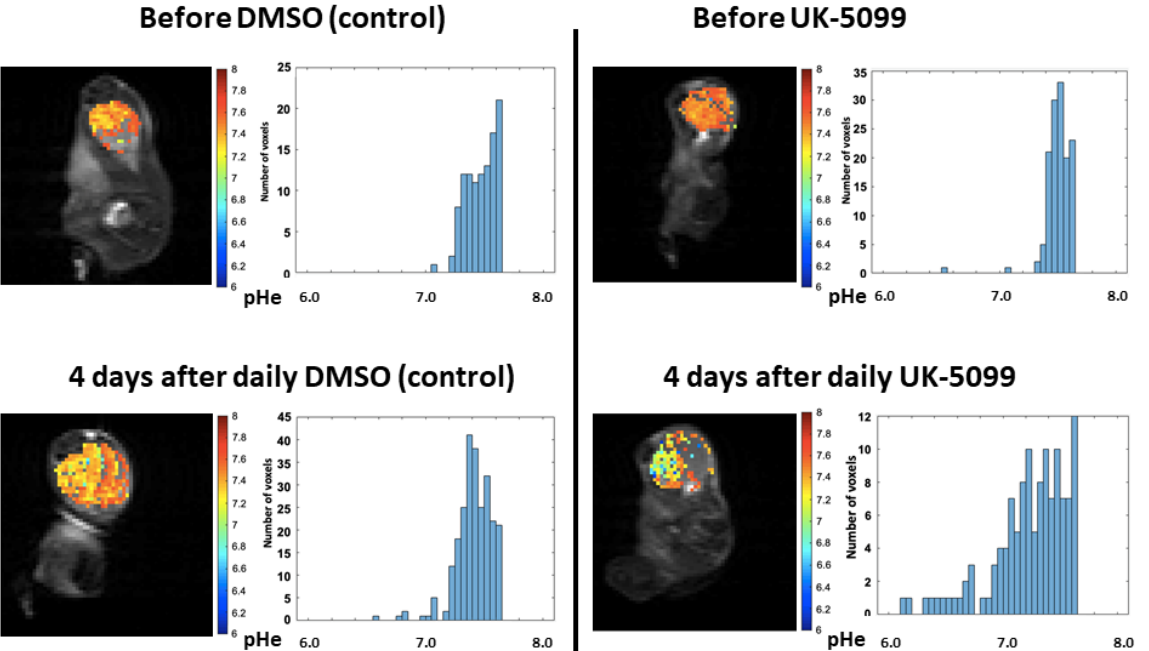
Figure 5. Evolution of pHe evaluated by CEST-MRI. Typical images and histograms of distribution of pHe values recorded before and after vehicle administration ( left ), before and after UK-5099 administration ( right ) (daily IP injection during 4 days, 3 mg/kg). Images are recorded on the same mice. Note that the pHe values remained rather identical in the control group while there is a clear shift in pHe towards more acidic values. Note also the large heterogeneity of pHe values recorded after the UK-5099 treatment.